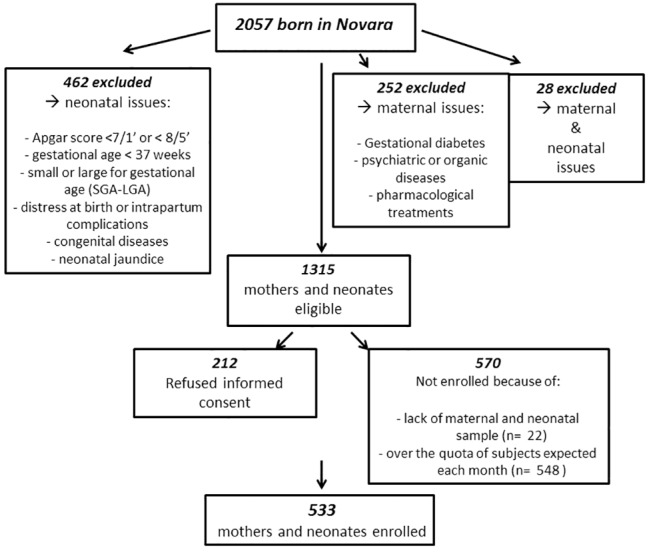
Flowchart of the enrolled subjects.